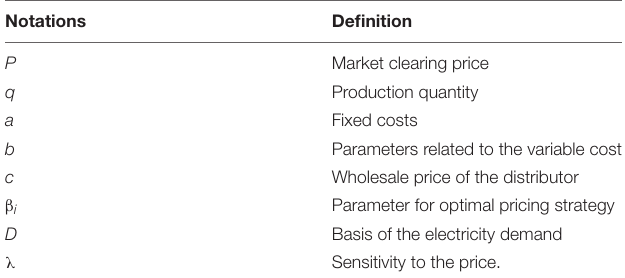
TABLE 1 | The notations of